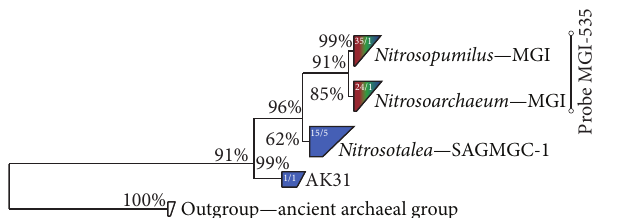
Figure 5: Bootstrapped maximum likelihood tree of sequenced 16S rRNA genes (GTR-GAMMA method, 1000 iterations). Blue colour indicates clones derived from River Maggia, while green and brown indicate clones fromLake Maggiore fromspring (March)and autumn (September). Clusters in brown, green, and blue contain sequences from all three clone libraries. Numbers inside clusters refer to the number of sequences and OTUs, respectively. The bar at the bottom applies to 10% sequence divergence. The Nitrosopumilus (MGI) cluster contains sequences of N. maritimus (CP000866), “ Ca . N. koreensis ” (CP003842), and “ Ca . N. salaria ” (AEXL02000090); thecluster Nitrosoarchaeum containssequencesof“ Ca . N.koreensis ” (AFPU01000001) and “ Ca . N. limnia ” (AHJG01000224). The other two clusters include sequences of uncultured Archaea (reference sequences are HE589644 and KC437195 for SAGMGC-1 and AK31, resp.). For more details, see Figure S3 in Supplementary Material available online at